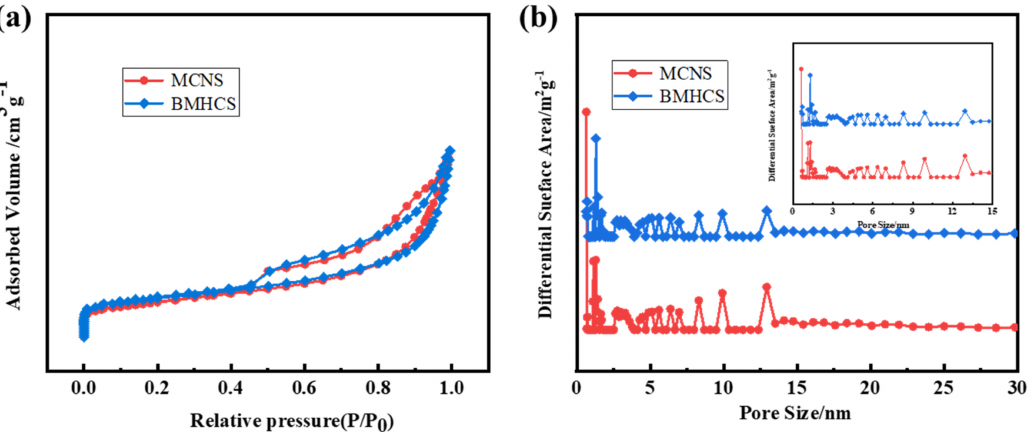
Figure 6. ( a ) N 2 adsorption − desorption isotherms; ( b ) Pore width distribution curves of MCNS and BMHCS.